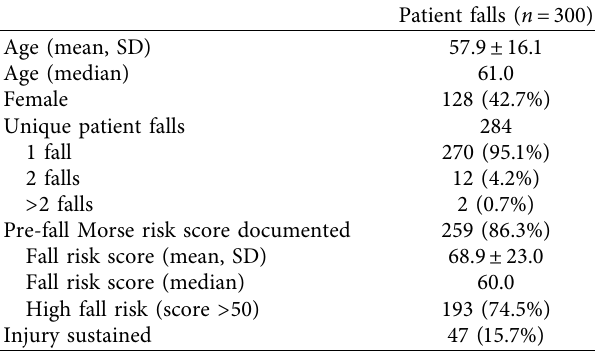
Table 2: Description of